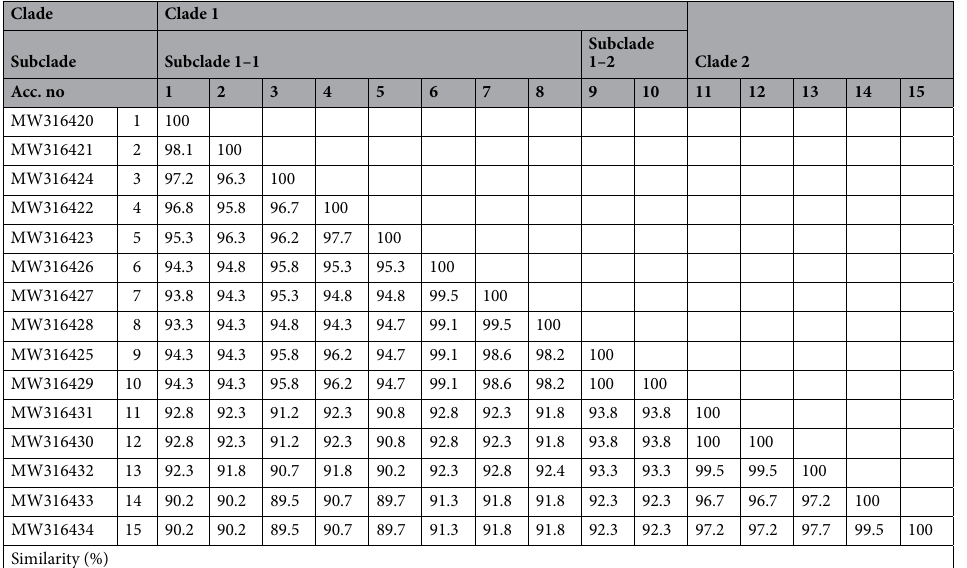
Subclade Clade 2Subclade Subclade 1–1